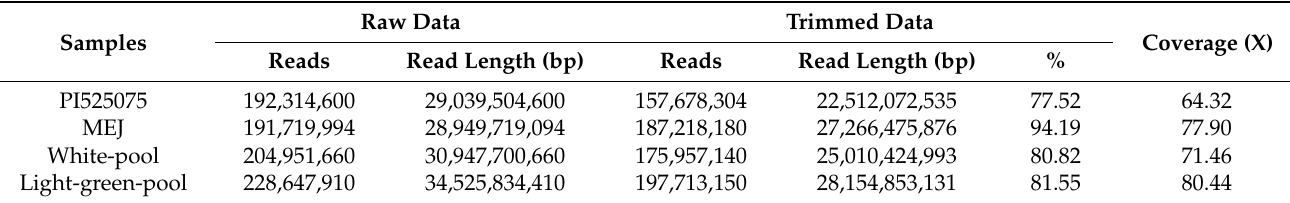
Table 2. Summary of whole genome re-sequencing data used for QTL-seq analysis.